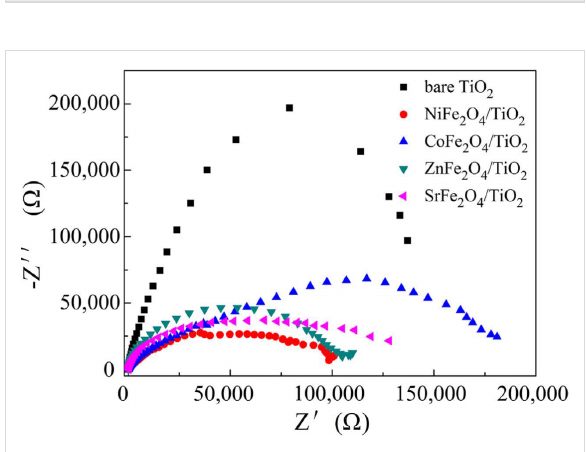
Figure 5: I – V (current intensity–applied voltage) curve. Reprinted from [97], an article distributed under the Creative Commons Attribution 4.0 license http://creativecommons.org/licenses/by/4.0/ copyright the authors of [97].